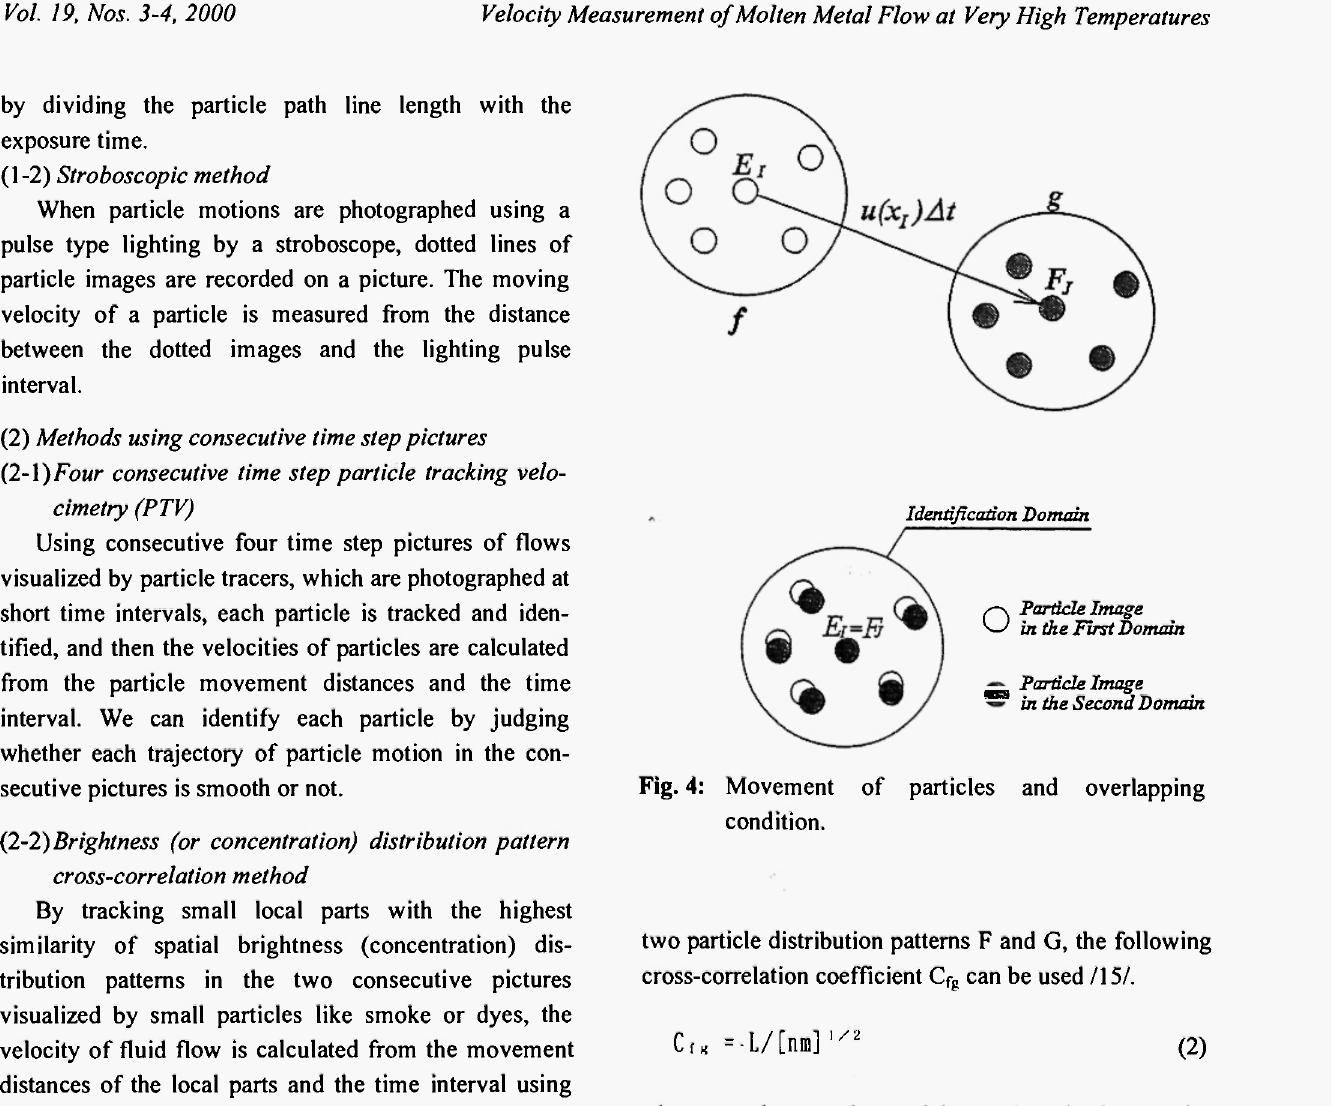
Fig. 4: Movement of particles and overlapping